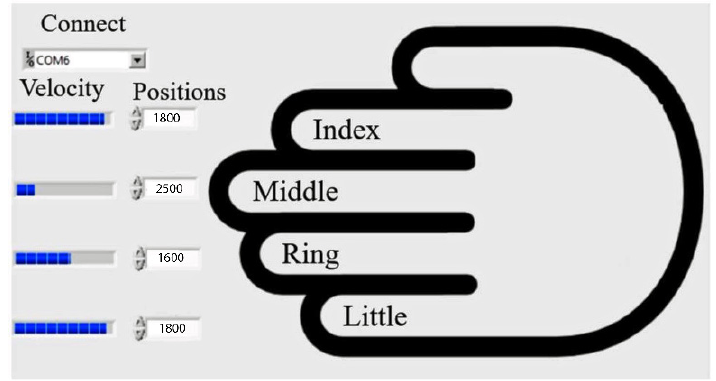
Figure 11. The developed graphical user interface.